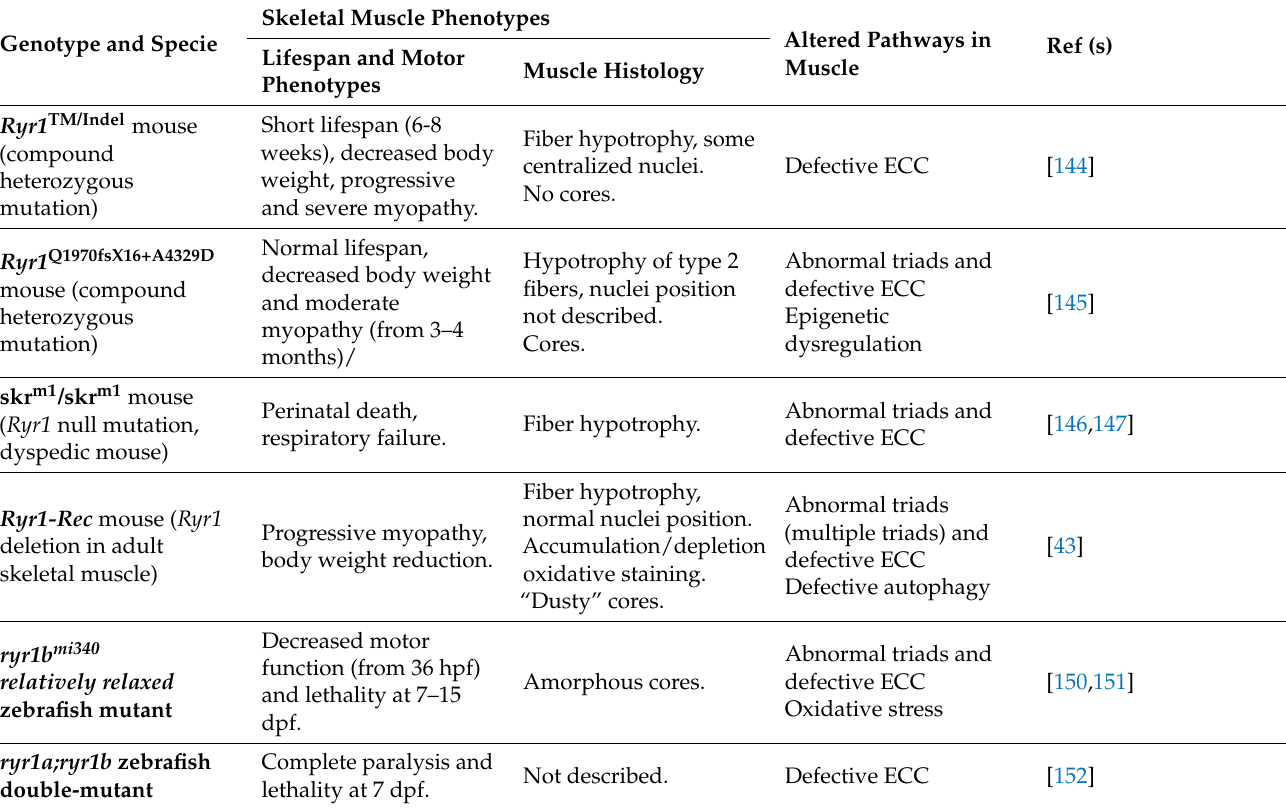
Table 5. Main fish and mammalian models for RYR1-related